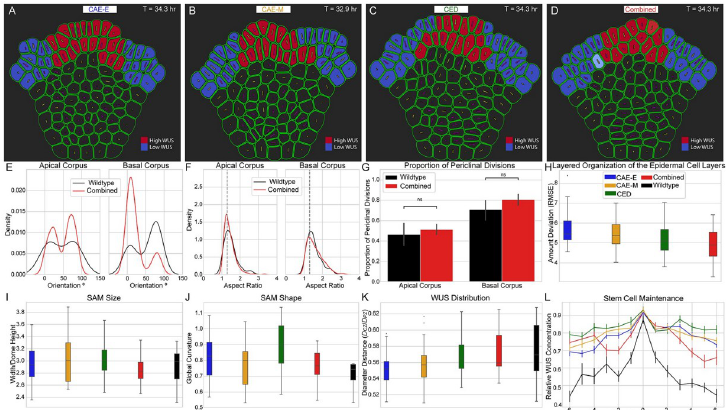
Fig 8. Layer-specific combined chemical and mechanical regulation of cell division plane orientation maintains proper shape, multi-layered structure and spatial distribution of WUS in the SAM. (A-D) Typical simulation output after 40 hours of growth for all four mechanisms (CAE-E, CAE-M, CED, and combined CAE-M and CED) in wildtype signaling conditions. Cell color highlights distinct patterns of WUS accumulation in the epidermal L1 and L2 cell layers for each mechanism (red = high WUS and blue = low WUS). (E-F) The combined CAE-M and CED mechanism resulted in distributions of (E) mother cell orientations that were similar to experiments and (F) cell aspect ratios that matched experiments. (G) The proportion of periclinal cell divisions in combined CAE-M and CED simulations were found to match experiments. (H) The combined CAE-M and CED mechanism resulted in the smallest amount of deviation from a single-cell layer in the epidermal L1 and L2 cell layers. The combined CAE-M and CED mechanism most closely matched experimentally observed SAM (I) size- the ratio of SAM width to dome height, (J) shape- global curvature of the SAM surface, and (K) WUS distribution in the SAM after 40 hrs of growth. (L) The combined CAE-M and CED mechanism resulted in the correct number of high WUS containing cells in the epidermal L1 cell layer. (E-L) Experimental wildtype (black), CAE-E (blue), CAE-M (gold), CED (green), and combined (red) in all panels. See S3 Appendix for detailed description of all metrics used in this Figure.